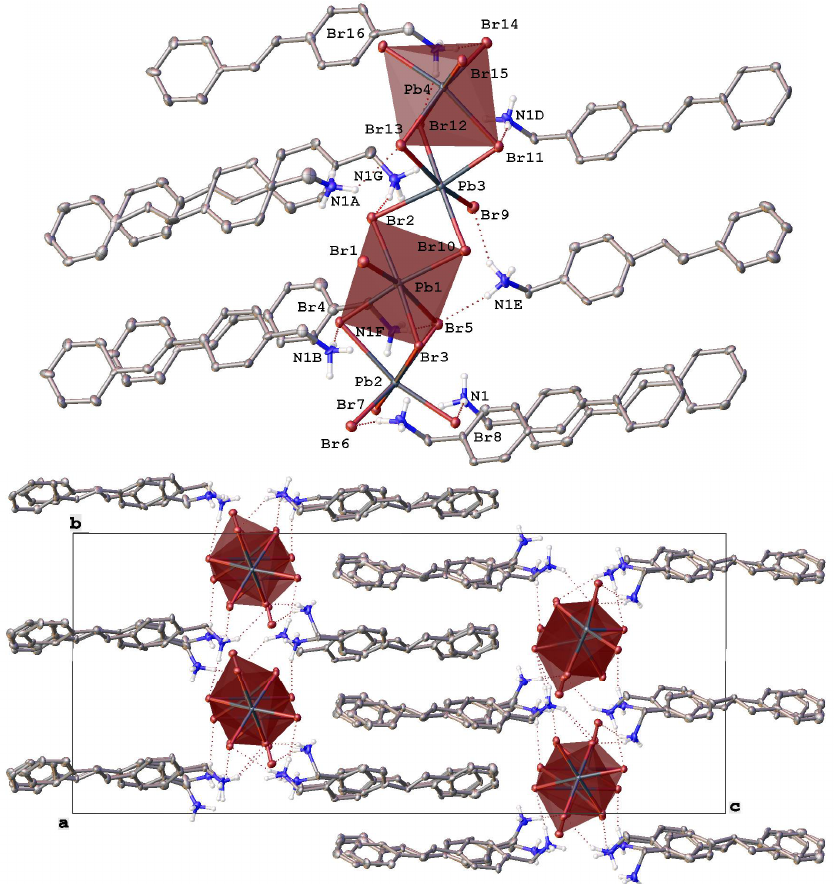
Figure 3. Fragments of the crystal packing in [StyrNH 3 ] 2 [PbBr 4 ] ( a ) illustrating the formation of mini-rods from lead bromide octahedra (highlighted by pink color) along the crystallographic axis a and ( b ) a view perpendicular to the crystallographic plane ab. Hydrogen atoms except those of NH 3 groups are omitted for clarity, non-hydrogen atoms are shown as thermal ellipsoids ( p = 30%) and only labels of the heteroatoms in an asymmetric part of the unit cell are given.